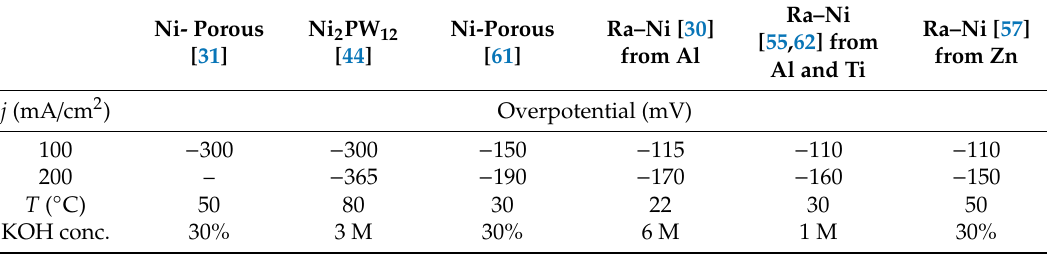
Table 3. Best alloys for HER found in the